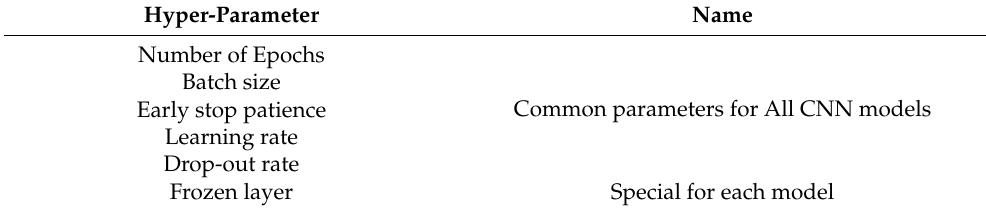
Table 2. CNN model